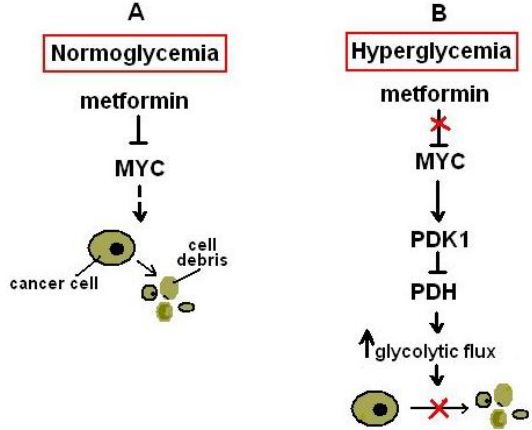
Figure 2. Pathways associated with the sensitivity or resistance of tumor cells to metformin under normoglycemic or hyperglycemic conditions. ( A ) Under normoglycemic conditions metformin opposes the expression of MYC and tumor cells display sensitivity to metformin-induced killing. ( B ) Under hyperglycemic conditions metformin-induced prevention of MYC expression is abolished. MYC upregulates the expression of pyruvate dehydrogenase kinase 1 (PDK1), which in turn inhibits pyruvate dehydrogenase. Glycolytic flux is therefore increased and tumor cells display resistance to the toxic effects of metformin. The red “X” symbol denotes inhibition of a signaling pathway. Upward pointing arrow denotes upregulation.